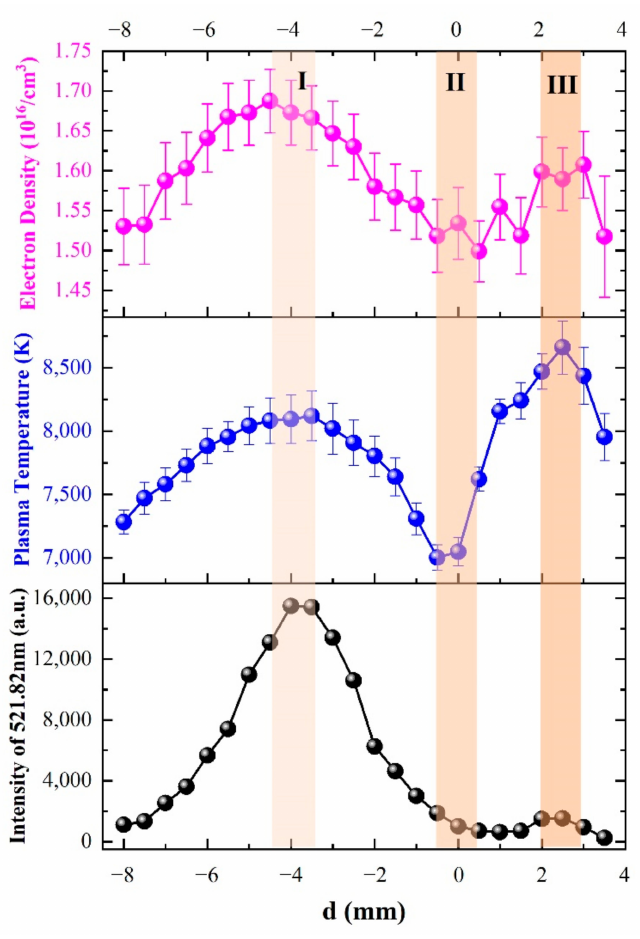
Figure 8. Variation in the electron density, plasma temperature and intensity of the spectral line at 521.82 nm with d